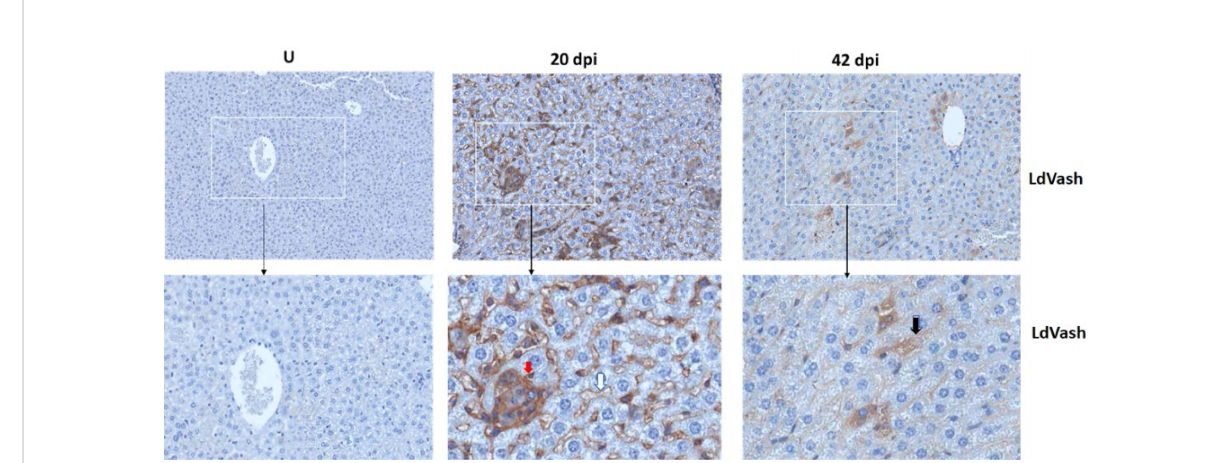
FIGURE 3 LdVash is released into the liver tissue of infected mice. BALB/c mice were infected by tail vein injection with L. donovani parasites. At 20 or 42daysafterinfection,miceweresacri fi ced,andtheirliverwasrecovered.Thetissueswereformalin- fi xedandthenprocessedforimmunohistochemical analyses.Sectionsfromuninfectedmice(U)andmiceinfectedfortheindicatedtimeswerelabeledwithacustom-madeRabbitanti-LdVashantibodyand counterstainedwithhematoxylin.Regionsofinterestinthewhiteboxesweremagni fi ed.Redarrowarrowspointtothelabelinthegranuloma,White